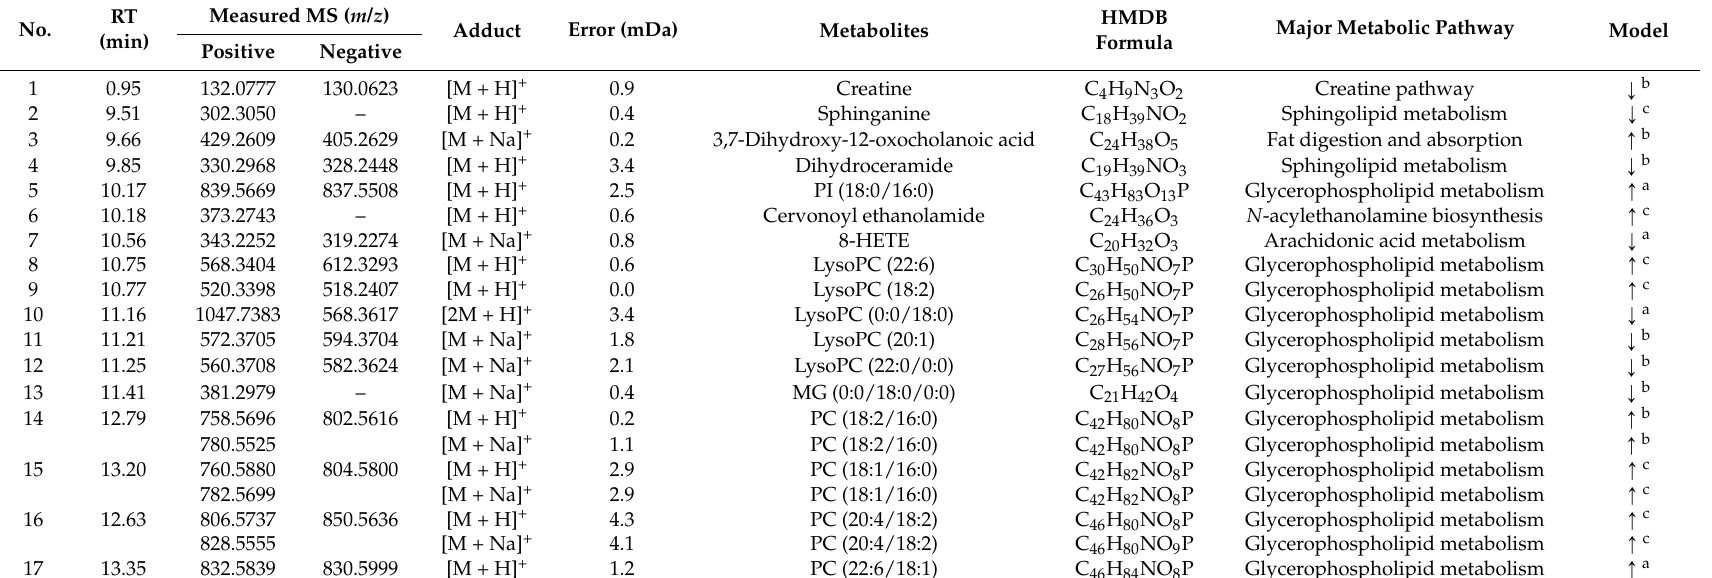
Table 2. The potential markers of the therapeutic approaches for hepatic